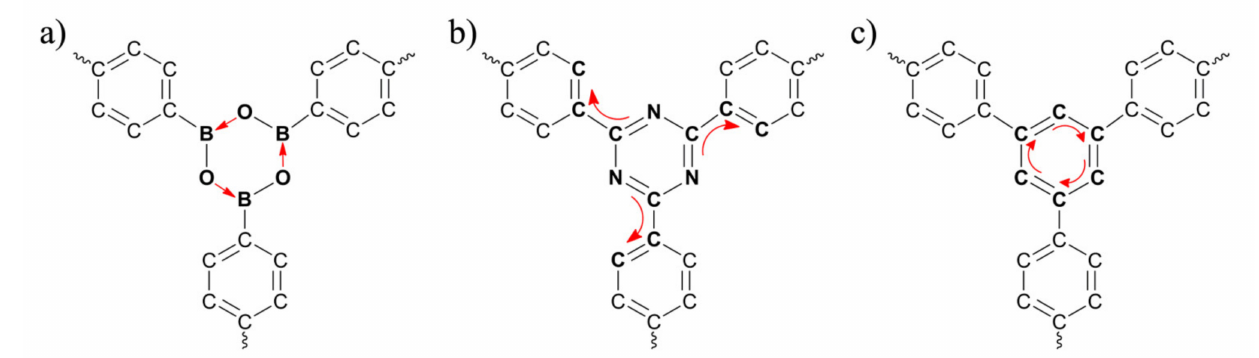
Figure 5. The strongest delocalization in ring B for ( a ) COF-1, ( b ) CTF-1 and ( c ) TPG.